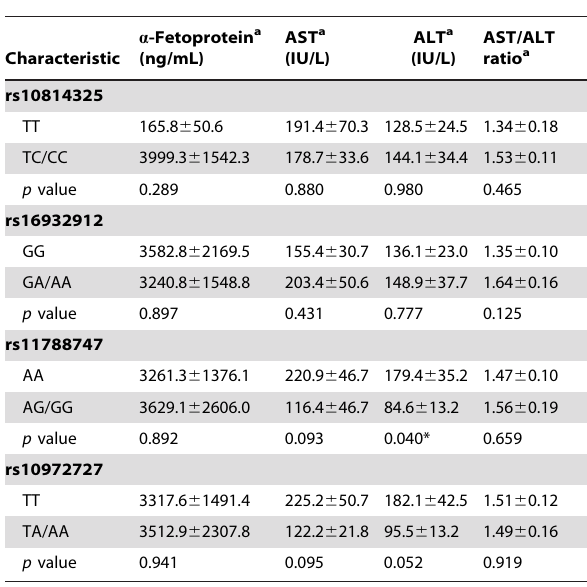
Table 6. Association of RECK genotypic frequencies with HCC laboratory